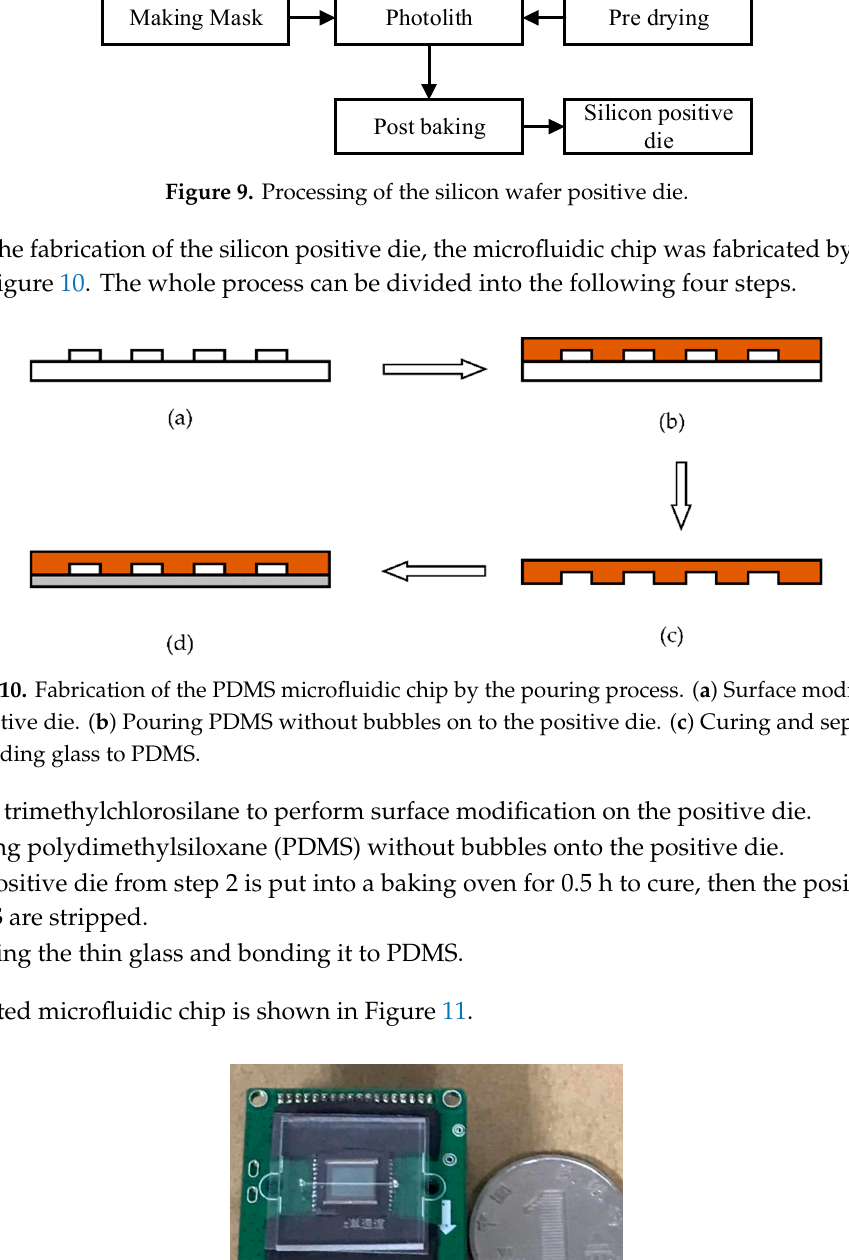
Figure 11. Comparison between the microfluidic chip and a renminbi (RMB) coin.